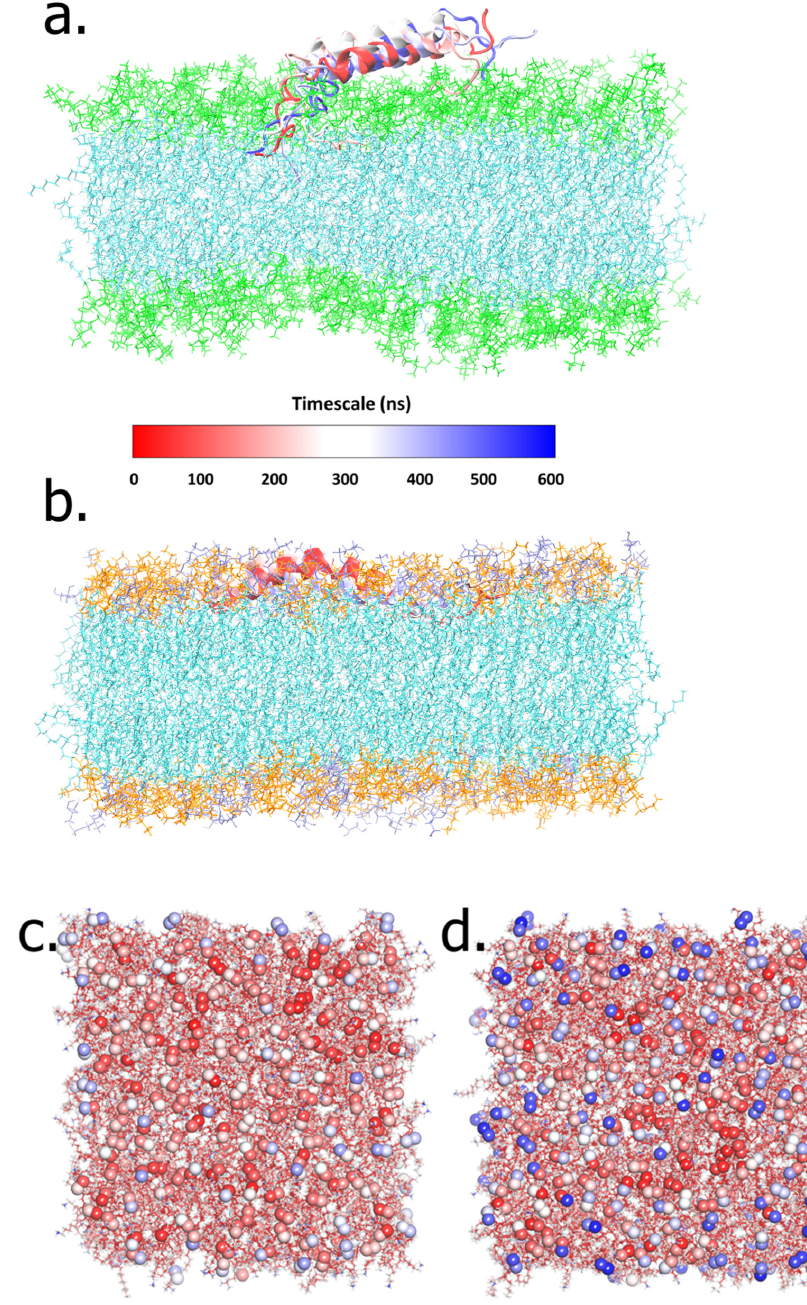
Figure 2. The overall interactions of LL-37 with the POPC (green) ( a ) and POPE:POPG (orange and purple) membrane ( b ) were presented in 150 ns intervals during 600 ns simulations. The exposure of the negatively charged phosphate group visualized by a ball model in ( c ) POPC and ( d ) POPE:POPG bilayer models. The gradual exposure of the water solvent from non-accessible to accessible is visualized by the red- to blue-colored balls.